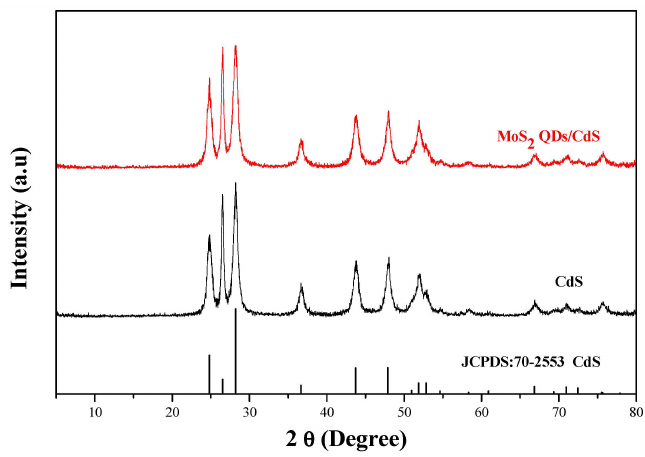
Figure 1. XRD patterns of the as-prepared CdS and MoS 2 QDs-CdS.